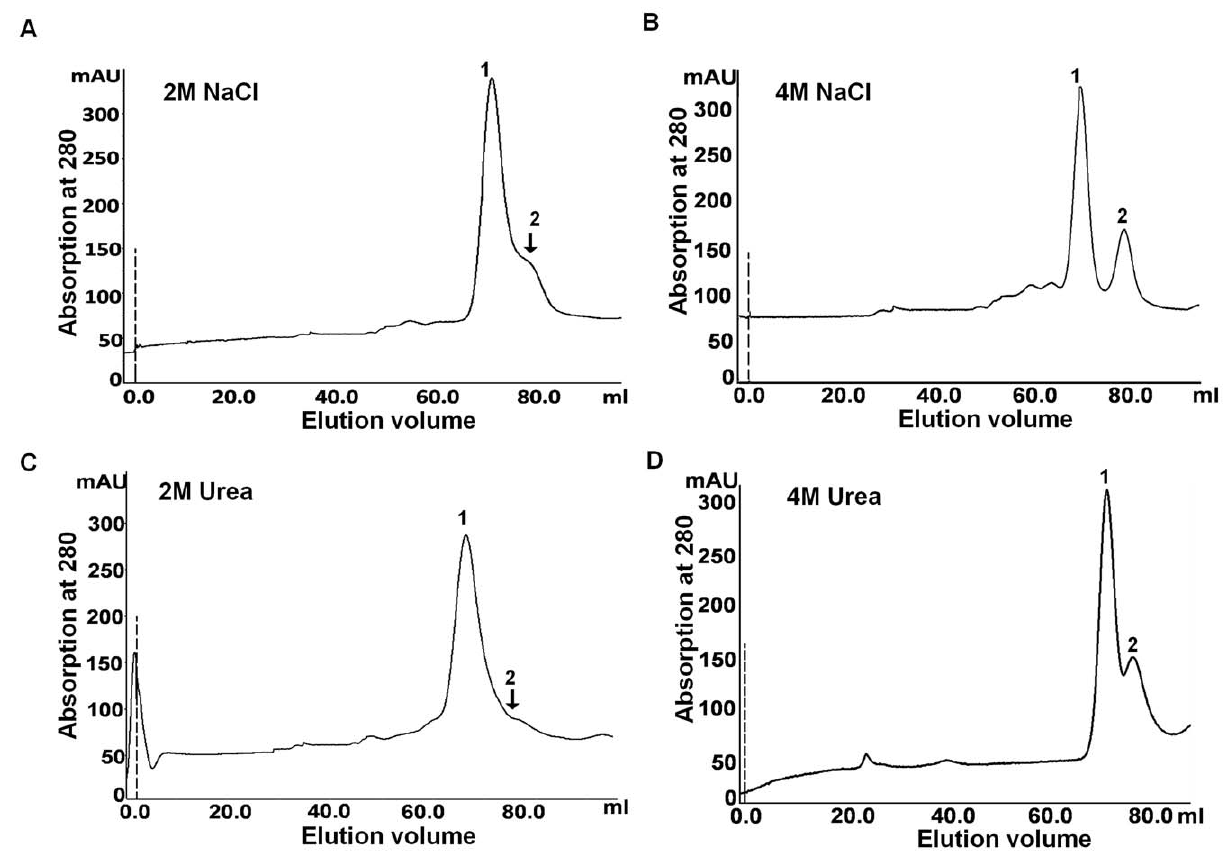
Figure 7. Effect of chaotropic agents on oligomeric property of Eh ODC. (A) & (B) Gel-filtration chromatogram showing the elution profile of Eh ODC protein treated with 2 M and 4 M NaCl respectively; (C) & (D) Gel filtration chromatogram showing the profile of protein treated with 2 M and 4 M urea respectively.